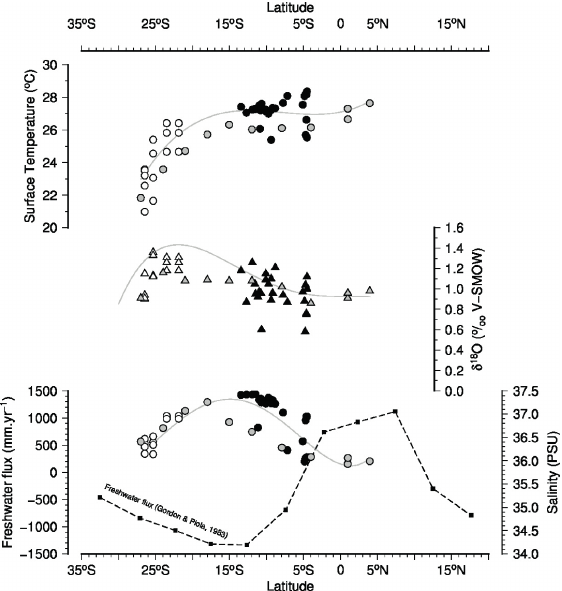
Figure 4 - Latitudinal distribution of surface temperature (top), δ 18 O (middle), salinity (bottom) and freshwater flux (dashed sw line in the bottom; Gordon and Piola 1983). the black symbols represent the present data, the white ones represent Pierre et al. (1991), the grey are Ostlund et al. (1987) data and the lines are the general trends (4 th degree